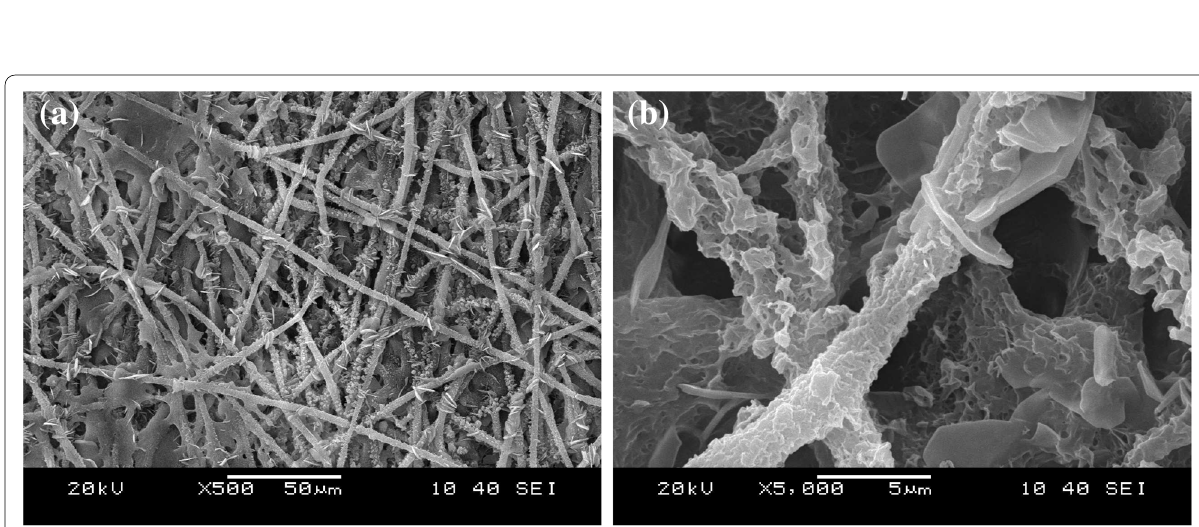
Fig. 4 SEM images of PHBV microfibers with 3wt.% SiO 2 -incorporated PHBV modified with a 5 wt.% SA-solution